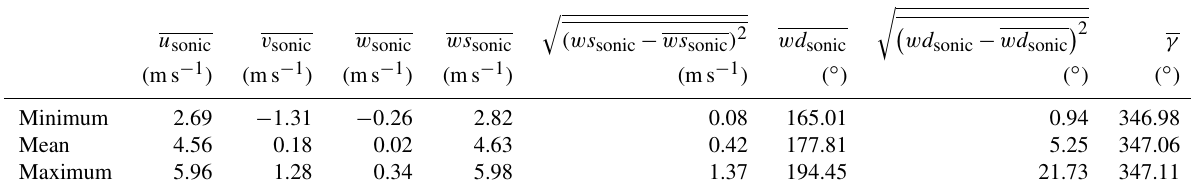
Table 1. Summary statistics of the 69 10min bins used for the validation study of inflow data. Data shown correspond to the sonic anemometer at 31.9m. The values ws sonic and wd sonic are the horizontal wind speed and wind direction, respectively. The value γ is the turbine yaw heading, which corresponds to clockwise rotation in the reference frame of Fig. 2.